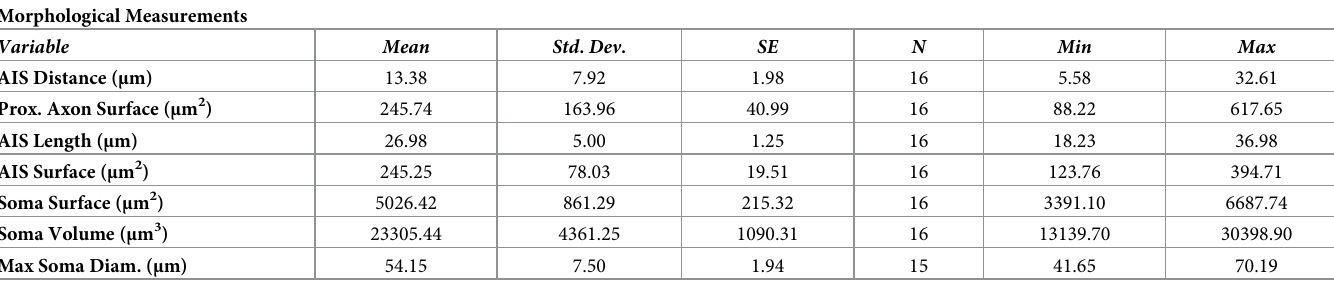
Table 2. Morphological characteristics of motoneurons and the